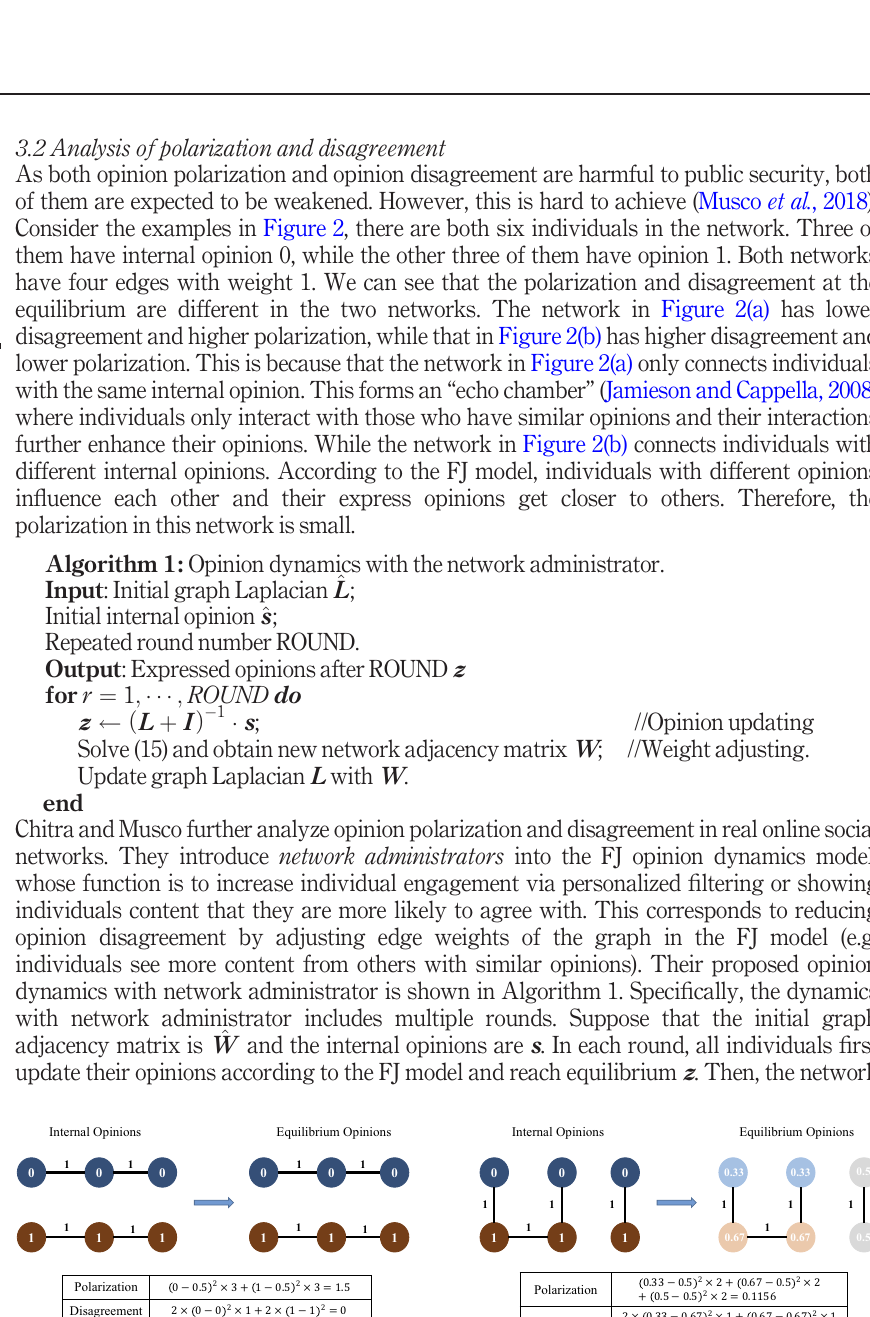
Figure 2. Two examples for polarization and